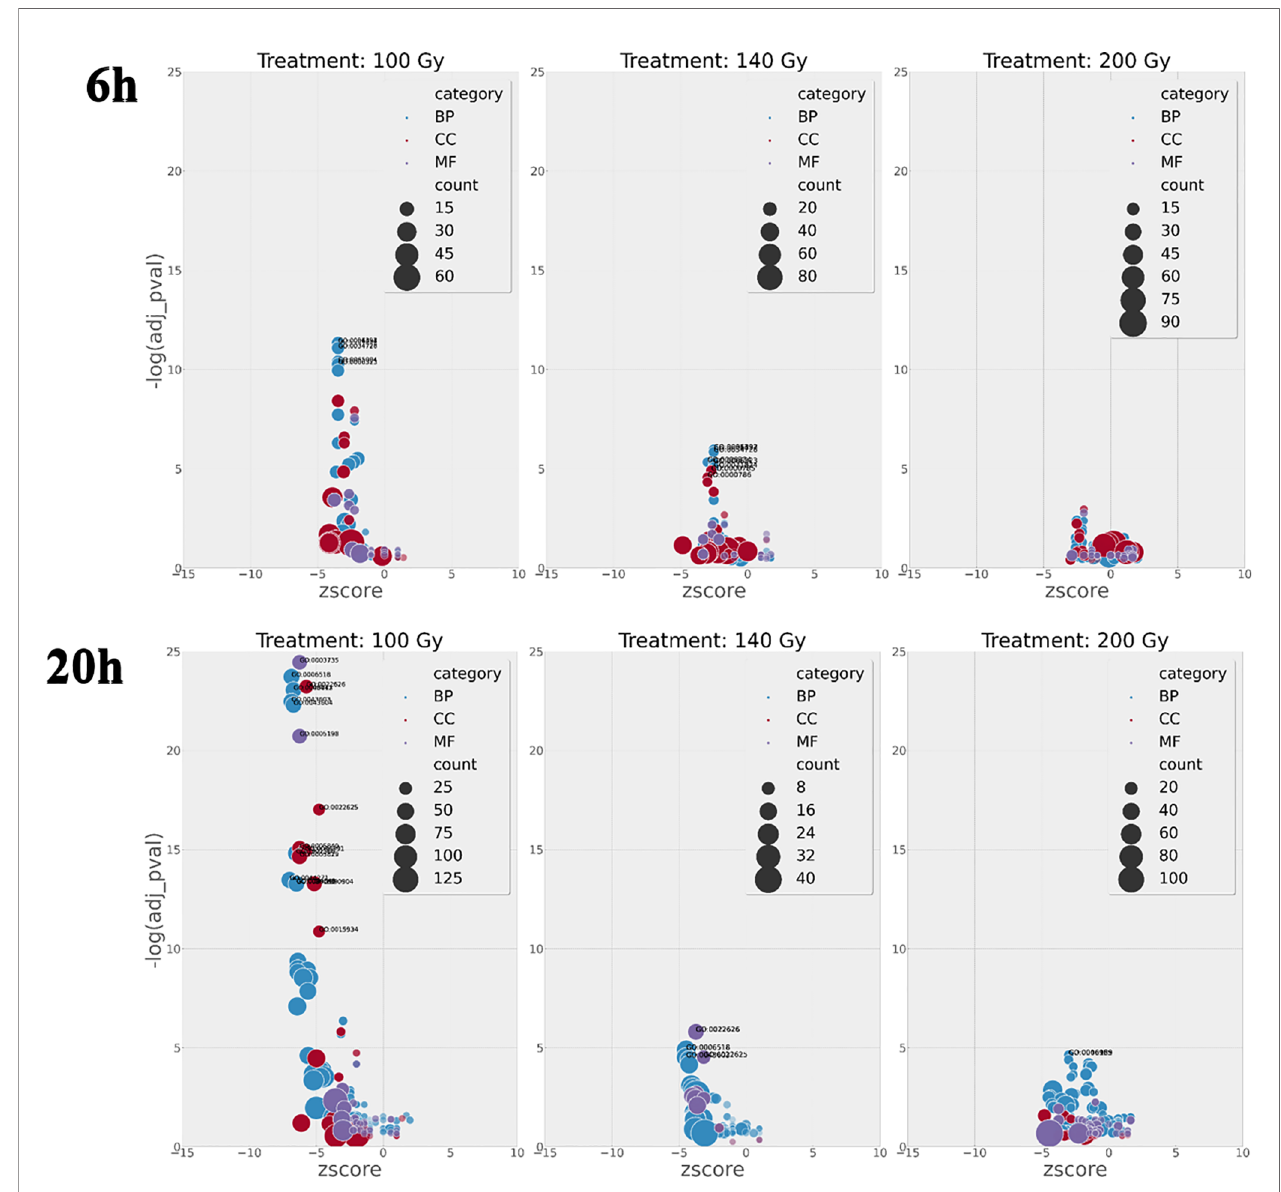
FIGURE 7 | GO enrichment terms with calculated Z scores plotted against FDR p value at 6h and 20h hours post-irradiation. The number of terms increases exponentially at 100Gy irradiation after 6h and 20h when compared to 140Gy and 200Gy irradiation with negative log FDR p signi fi cance values 10 log higher at 100Gy 20h than 100Gy 6h. Adjusted p values are important as they designate if a process is more likely to